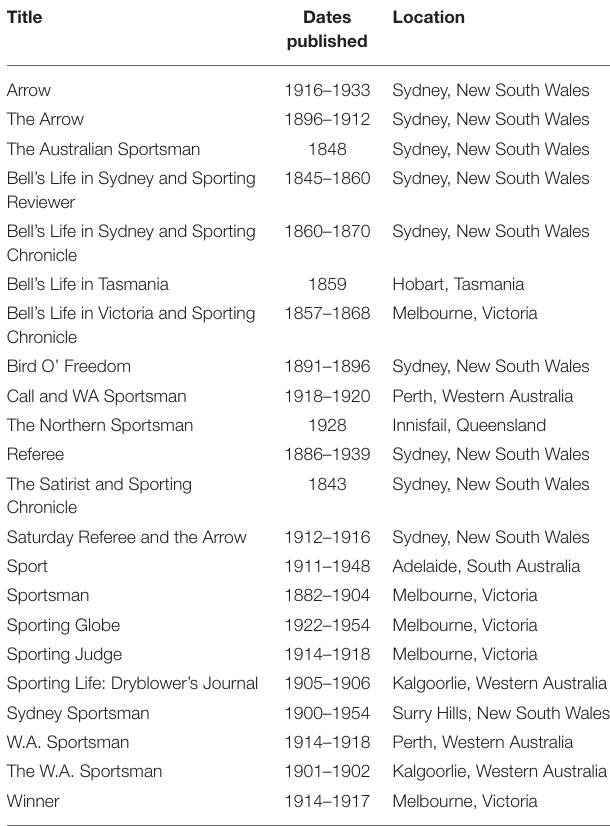
TABLE 1 | Historical terms used by Australian and international journalists to describe sporting brain injuries.